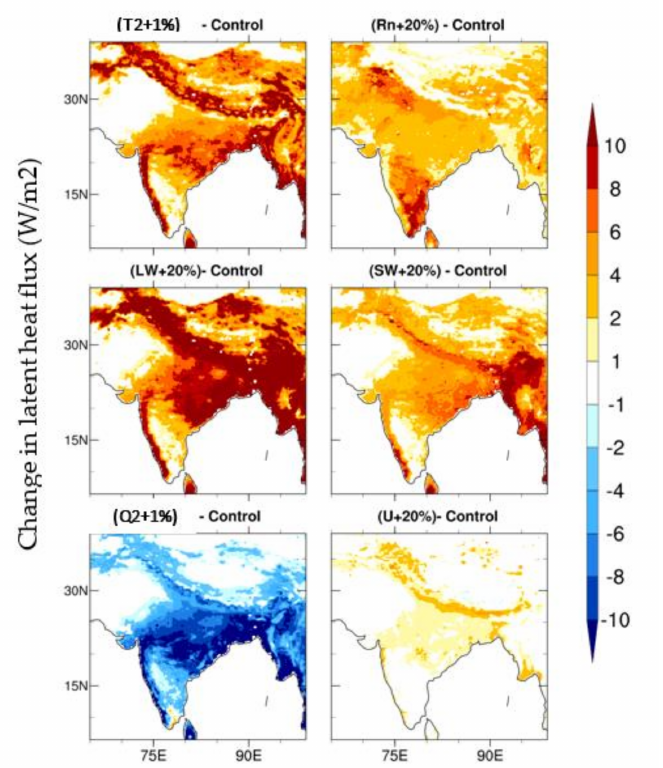
Figure 10. Annual latent heat flux change (W/m 2 ) due to the positive sensitive experiments compared to the control experiment during the year